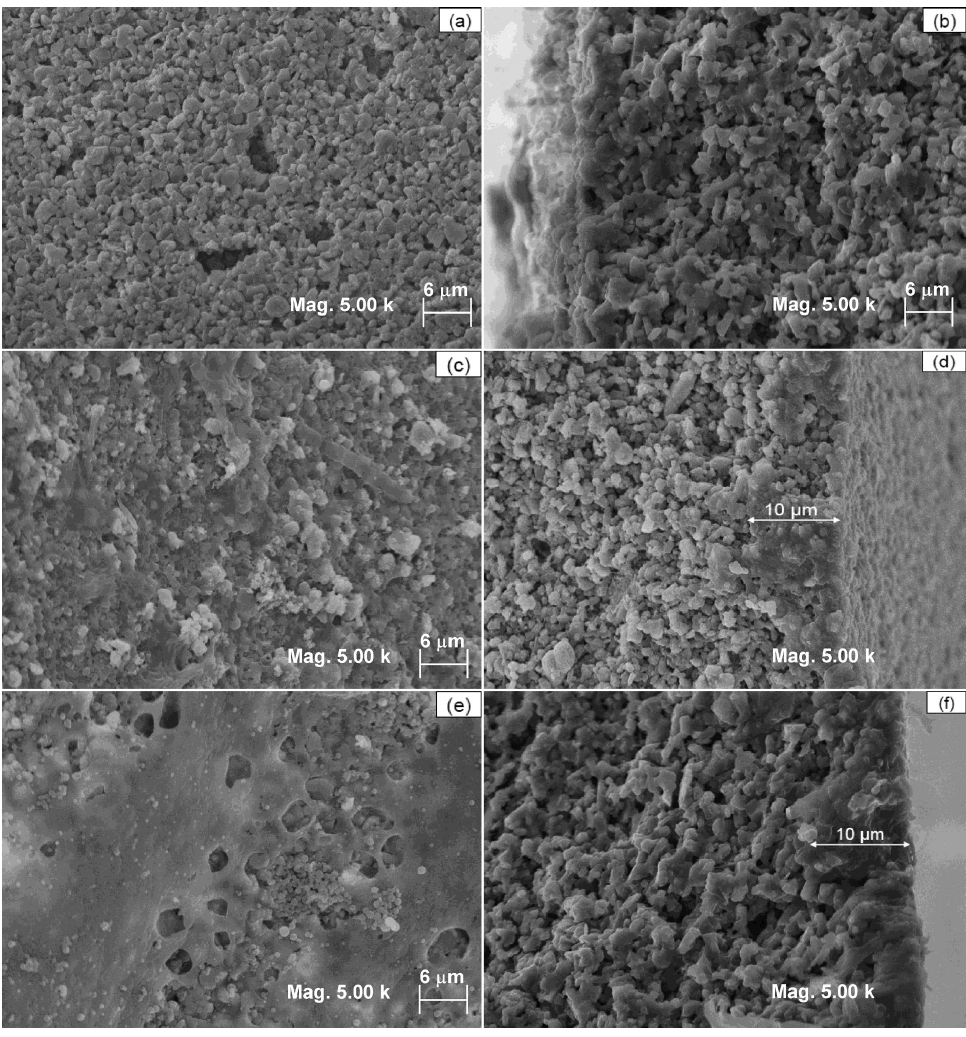
Figure 4. Micrographs obtained by SEM: (a) support surface, (b) support cross section, (c) surface of the membrane with one layer by dip coating process, (d) cross section of the membrane with one layer by dip coating process, (e) surface of the membrane with two layers by dip coating process and (f) cross section of the membrane with two layers by dip coating process.